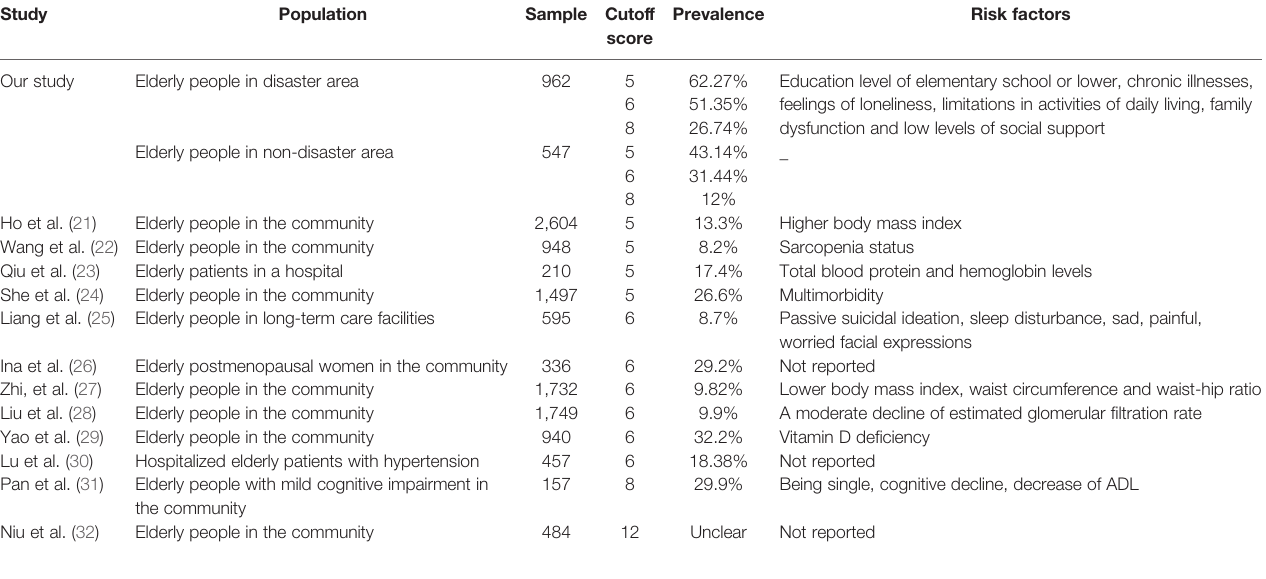
TABLE 1 | Prevalence of depression in older adults by the mean of GDS-15 score used in different studies in mainland